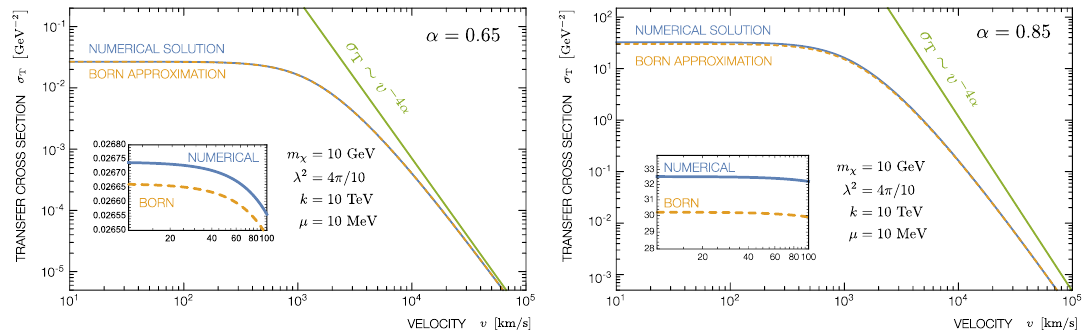
Figure 4 . Velocity dependence of the transfer cross section in the Born regime. Comparison between the Born approximation and (blue/solid) and the numerical result from a sum of partial waves (orange/dashed). The results asymptotically scale like v − 4 α at large velocity (green). Unlike the case of a Yukawa potential, there are no analytic expressions for the transfer cross section in the entire non-perturbative classical regime. 8 We show the scaling of the transfer cross section for the classical regime in the small mass gap/high velocity limit and give a closed form result in the low velocity regime below, see appendix